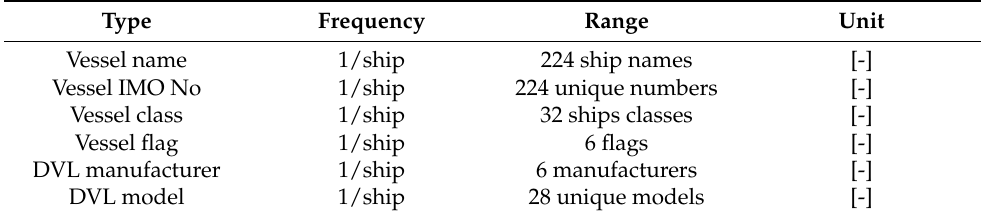
Table 5. Sampling frequency, range and units of general-info